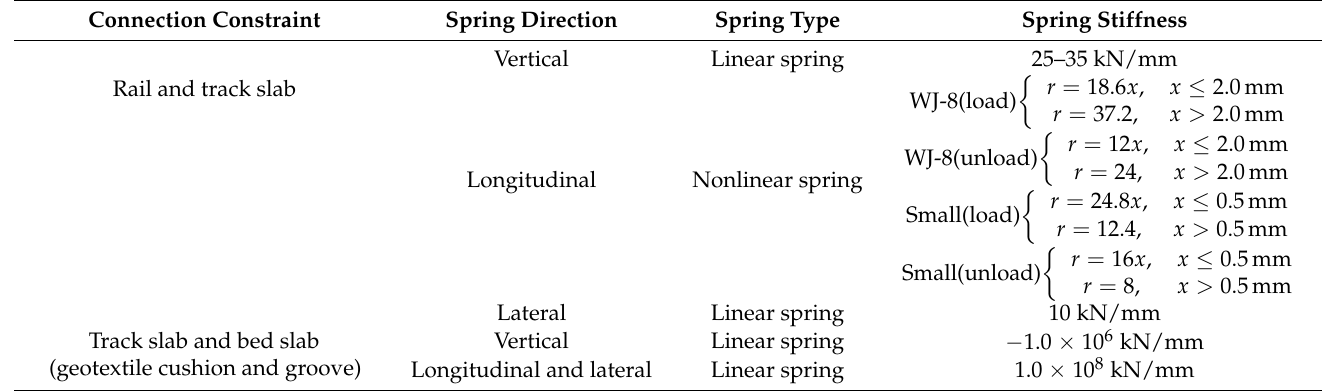
Table 2. Parameter values of constraints and connections.